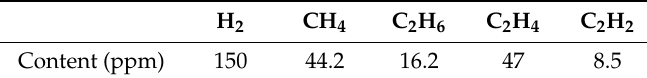
Table 8. Oil chromatographic data.